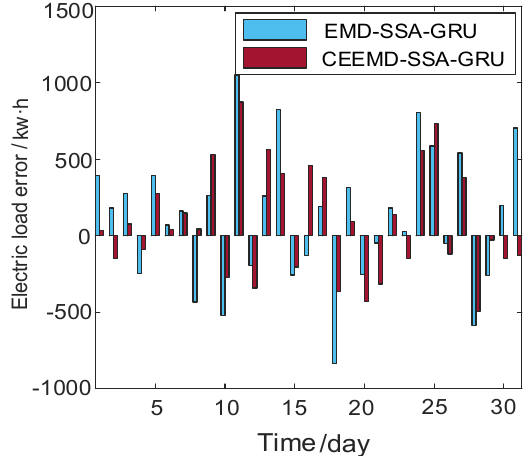
Figure 15. Comparison of power load error.